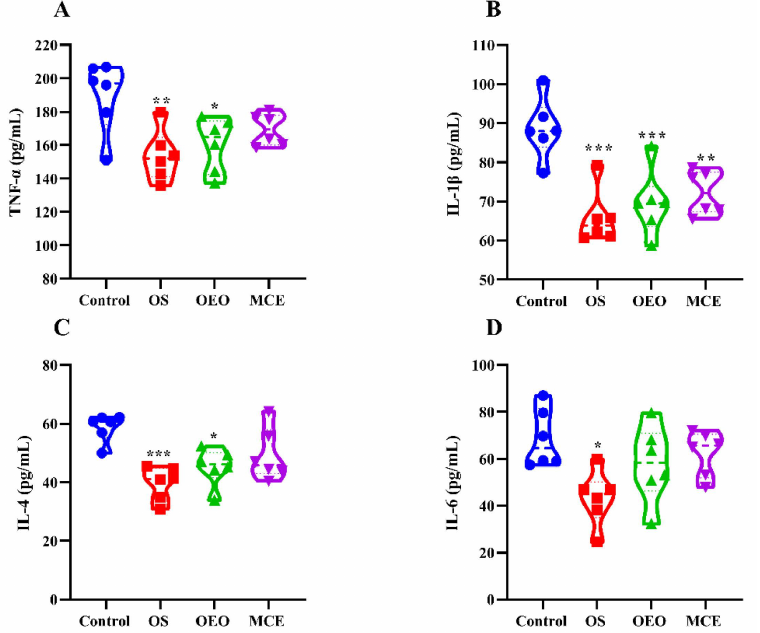
Figure 6. Serum cytokines of broilers. ( A ) Tumor necrosis factor- α (TNF- α ). ( B ) Interleukin 1 β (IL-1 β ). ( C ) Interleukin 4 (IL-4). ( D ) Interleukin 6 (IL-6). * p < 0.05, ** p < 0.01, *** p < 0.001, vs. control group ( n =